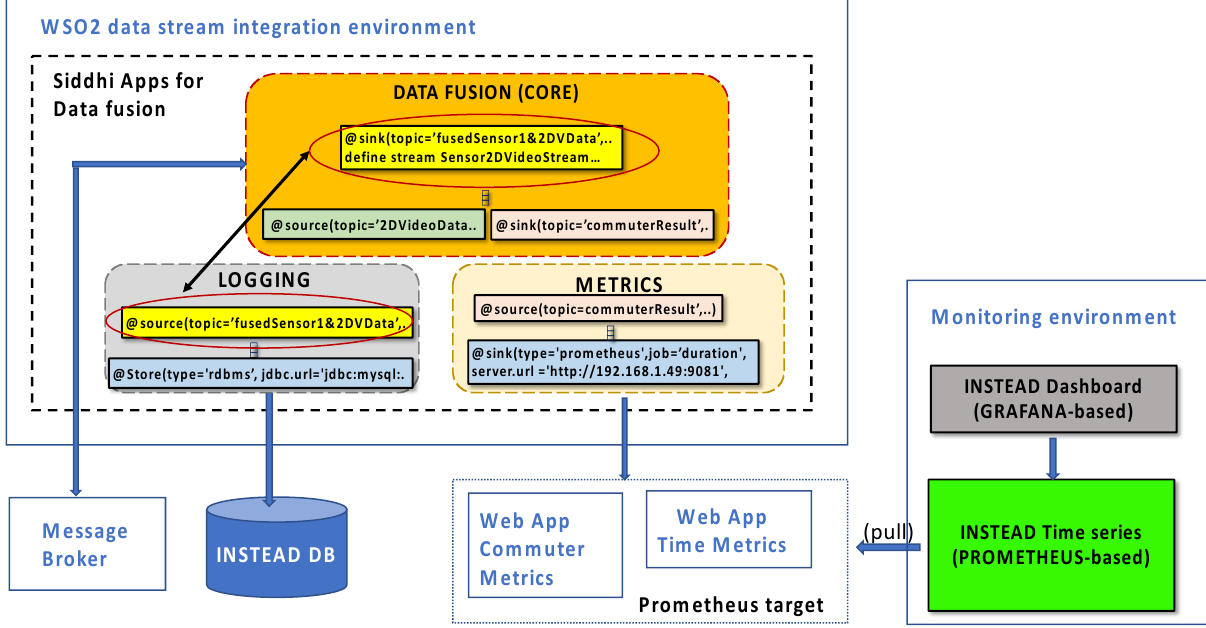
Figure 4. Software architecture of the Data fusion subsystem and communication between the components, internal and external 2D